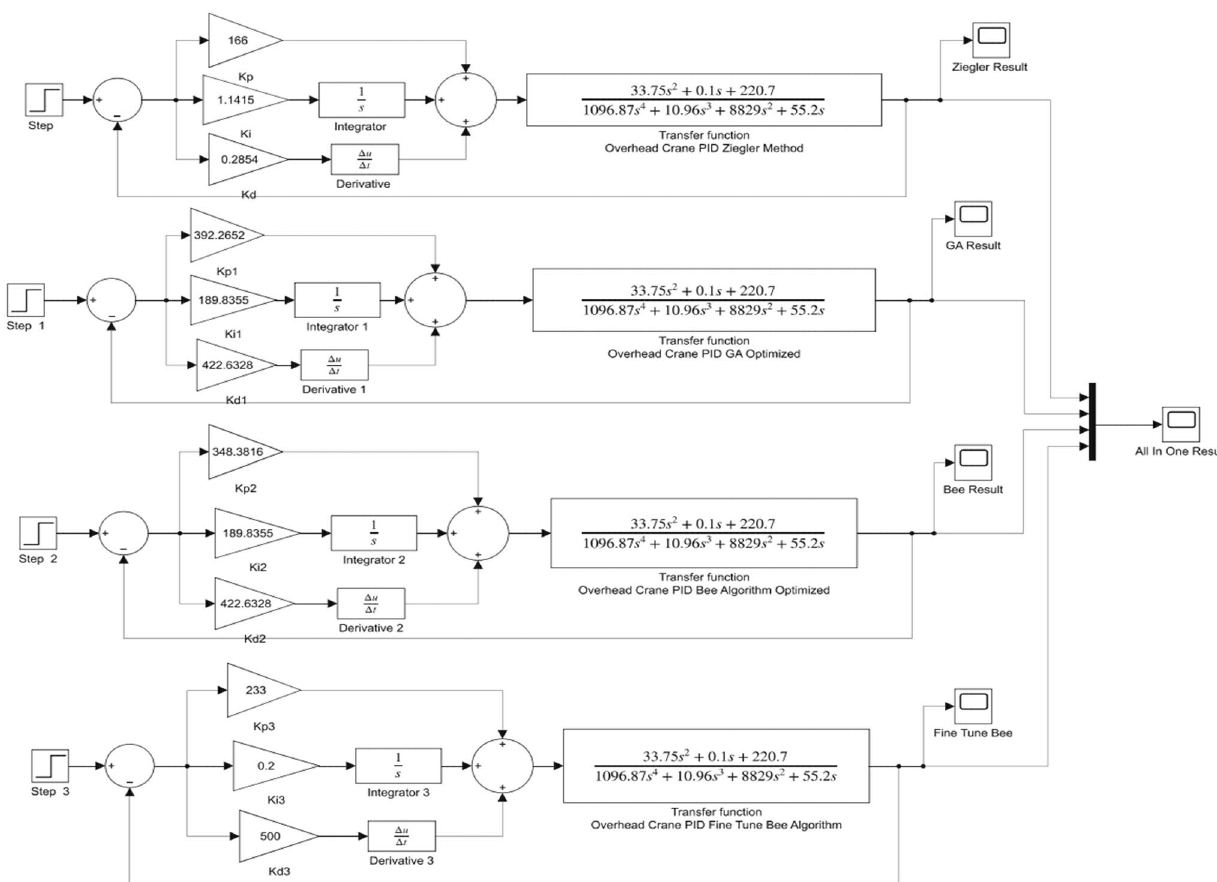
Fig. 4 Schematic diagram of PID control of overhead crane for different